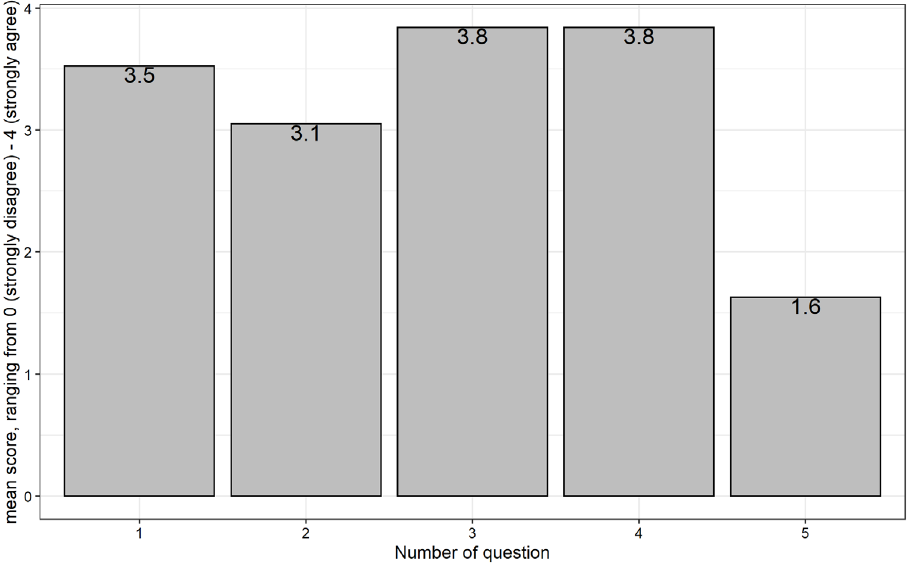
Figure 9. Average remote lesson experience (RLE) over all participants.